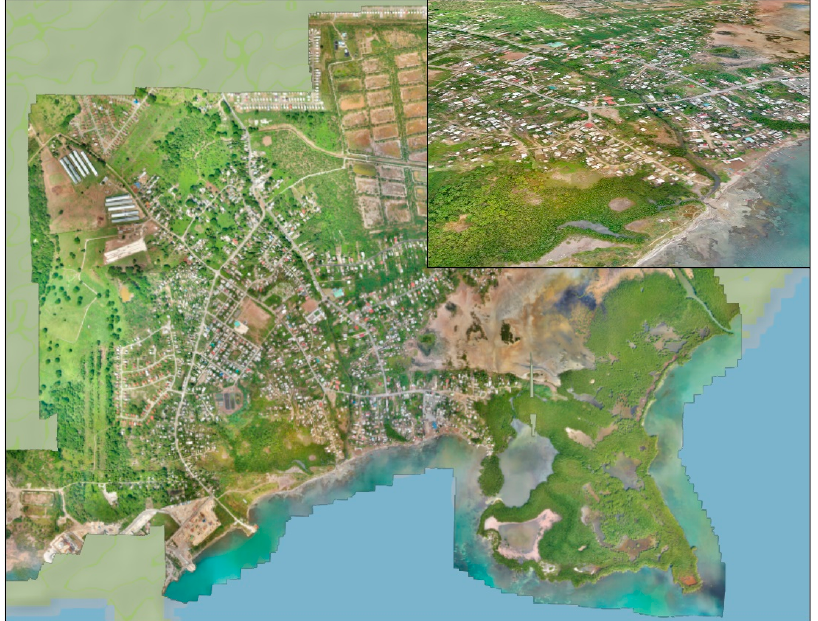
Figure 3. Orthophoto mosaic of Old Harbour Bay derived from 7352 Unmanned Aerial Vehicle (UAV) photos collected in November 2019 at a spatial resolution of 3.8 cm.